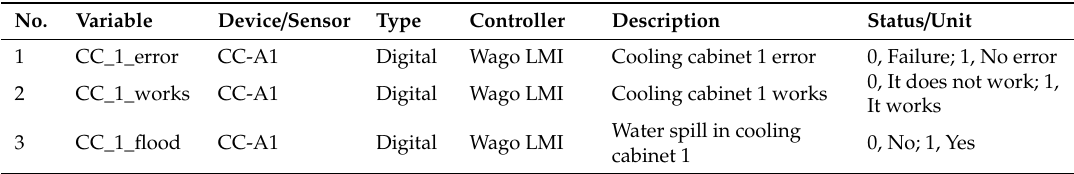
Table 5. An example of event definition and features for a cooling cabinet (CC_1).